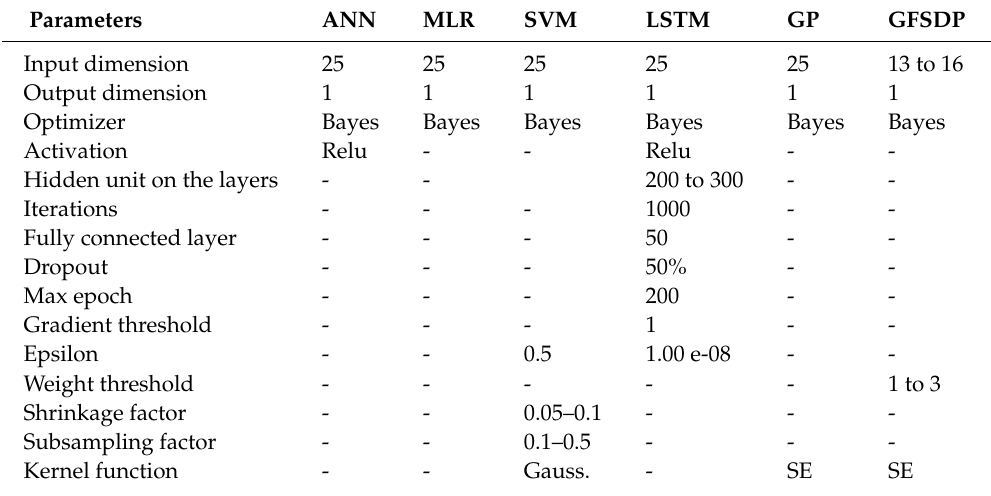
Table 5. Summary of the parameters of the proposed GFSDP and conventional algorithms, where SE is a squared exponential kernel for the GP algorithm.